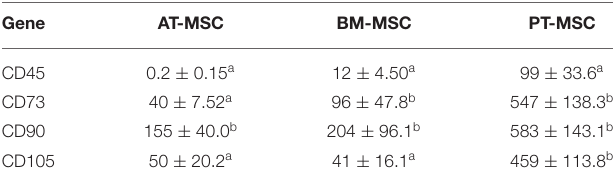
TABLE 3 | Mean values of expression of hematopoietic and mesenchymal genes relative to CD34 (mean ± SEM) (a, b) different letters represent significant differences ( P < 0.05) with respect to CD34 within the same